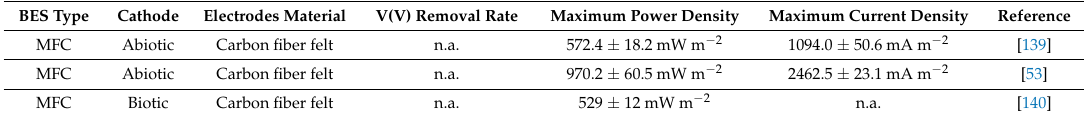
Table 5. Vanadium removal using